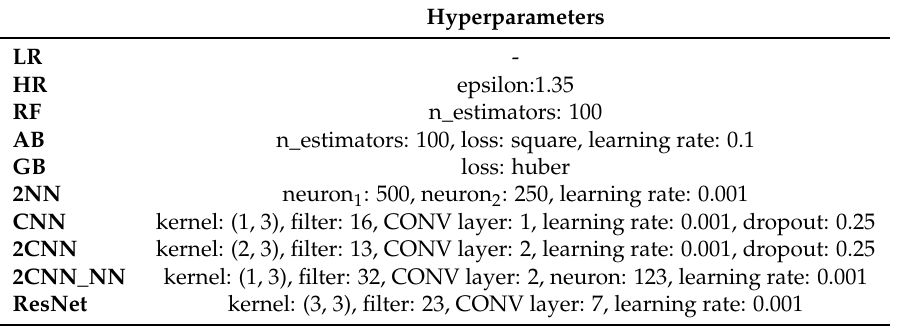
Table A1. Grid-search selected model hyperparameters. Benchmark model performance is optimised to select these. For a full specification and description of the models’ hyperparameters, we refer interested readers to